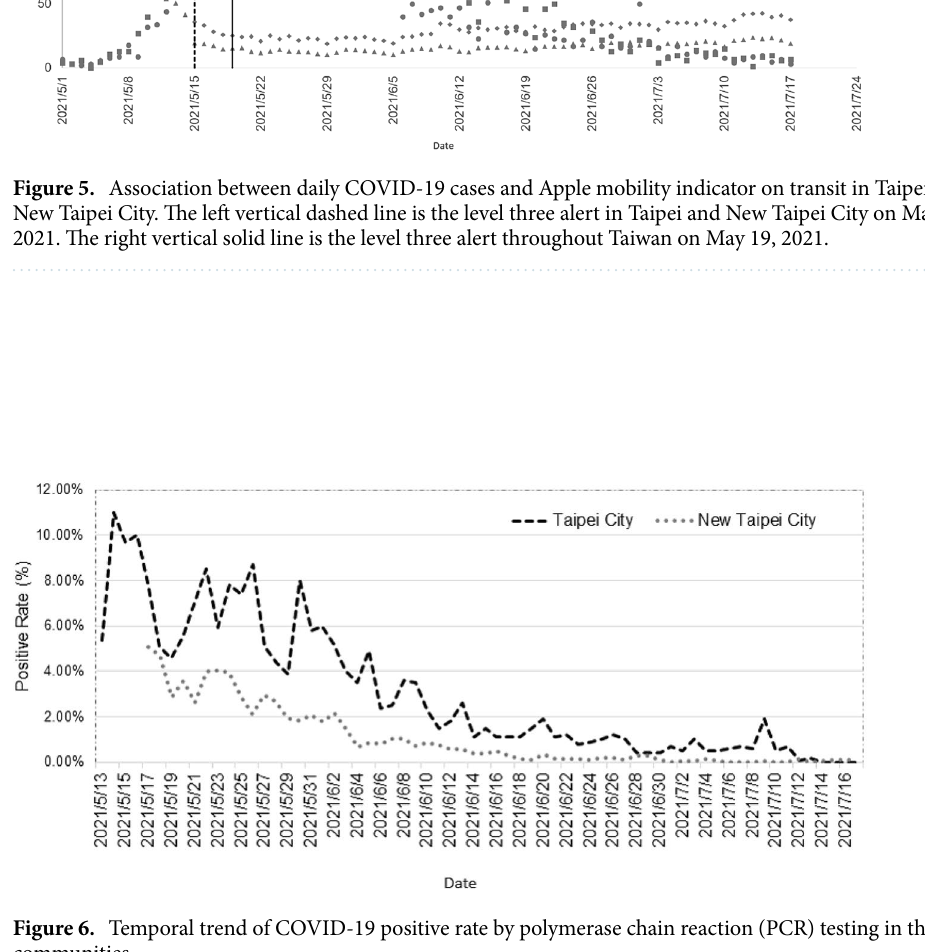
Figure 6. Temporal trend of COVID-19 positive rate by polymerase chain reaction (PCR) testing in the